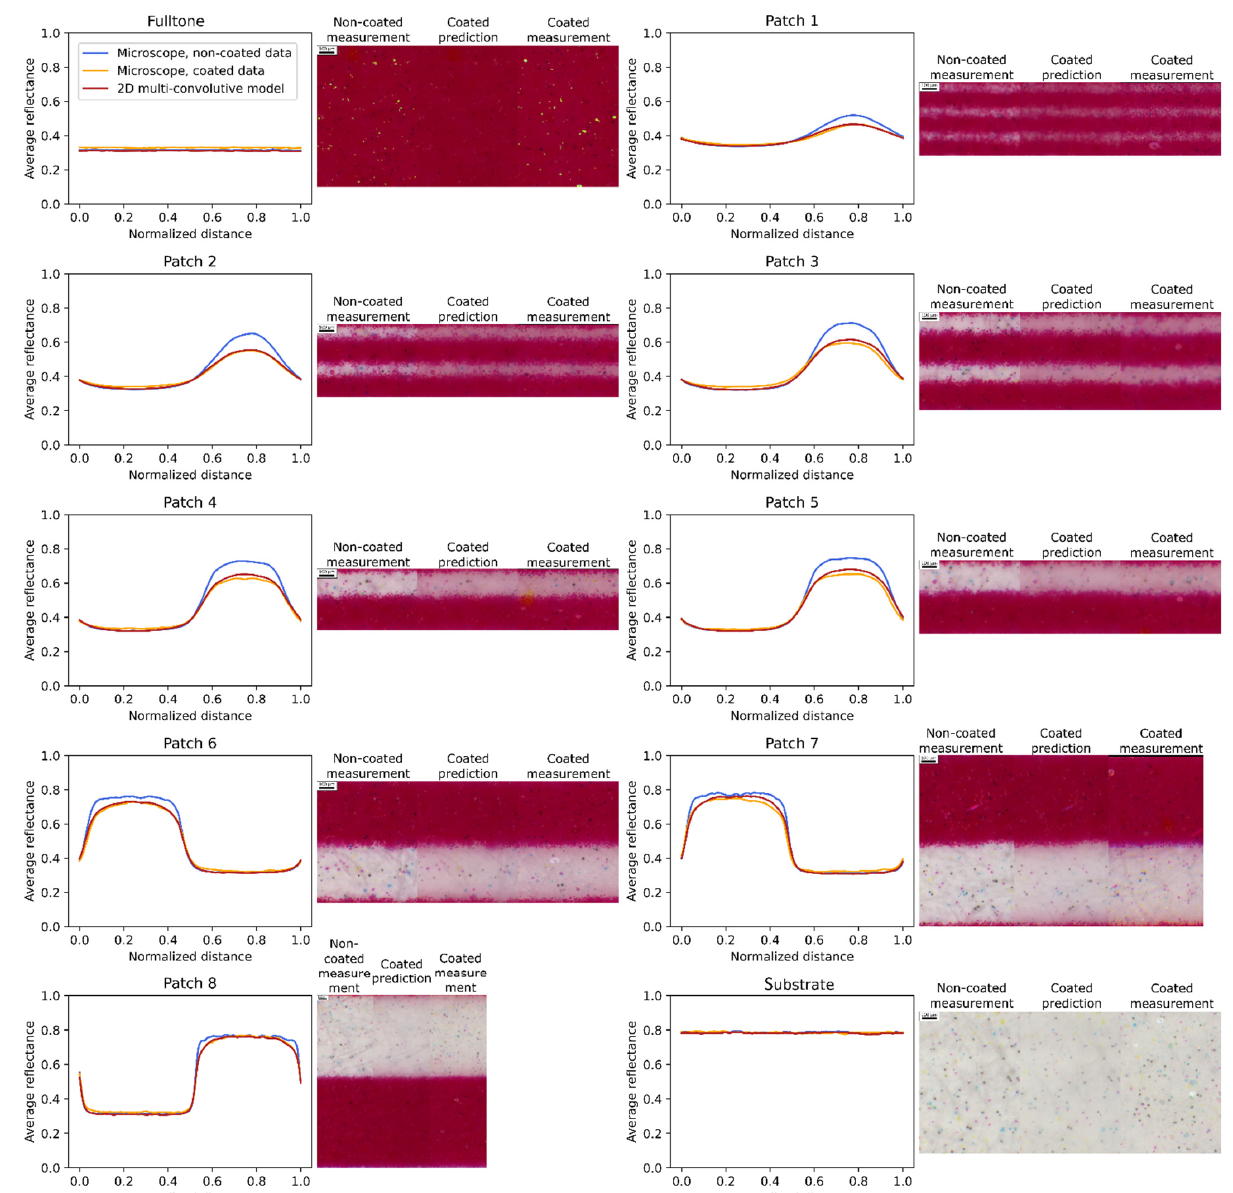
Figure 9. Magenta halftone reflectance profiles averaged over the spectral dimension. On their right, corresponding sRGB pictures of the non-coated, predicted, and coated halftones. Patch 1 to 8 have a period of 0.168, 0.252, 0.337, 0.421, 0.505, 0.839, 1.263, and 2.104 mm, respectively.